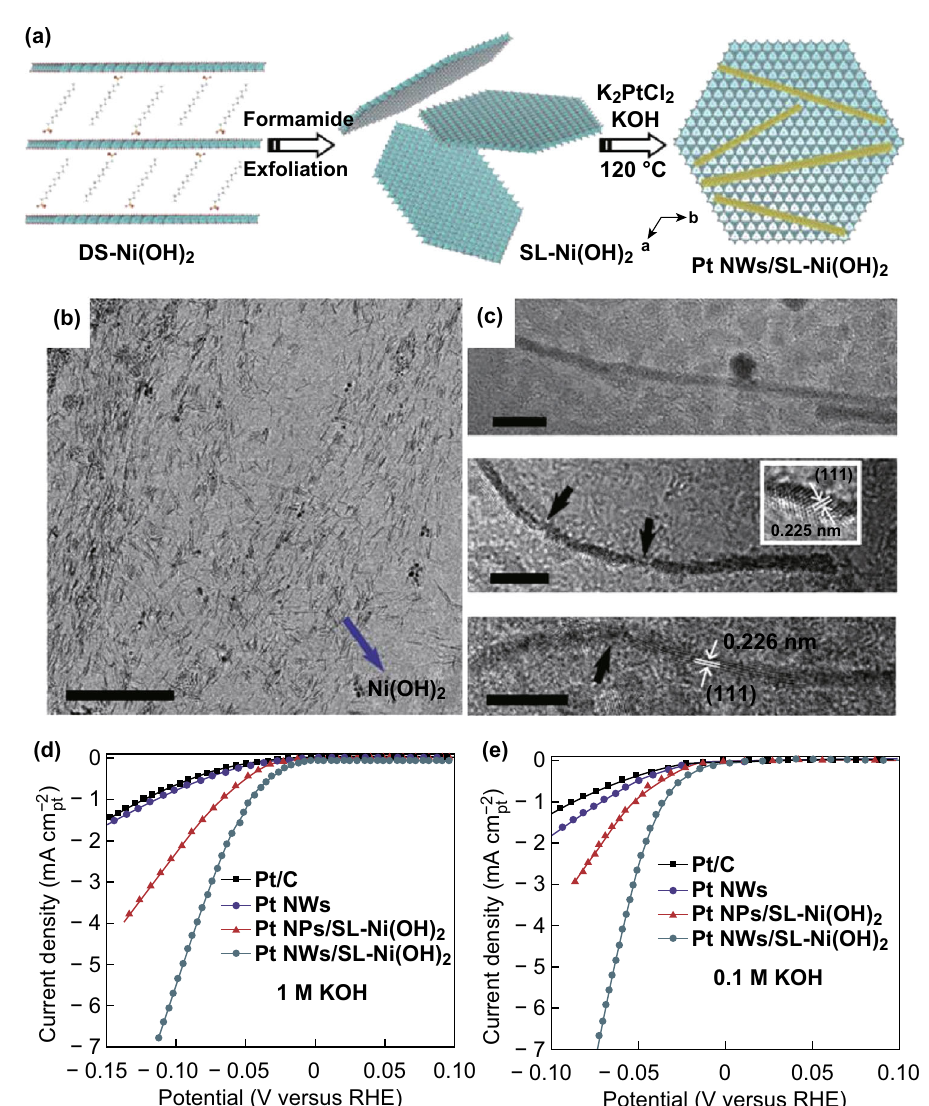
Fig. 2 a Schematic of synthesis of Pt NWs/SL–Ni(OH) 2 . b , c TEM images of Pt NWs/SL–Ni(OH) 2 ; scale bars in b and c are 100 and 5 nm, respectively. HER activity of Pt